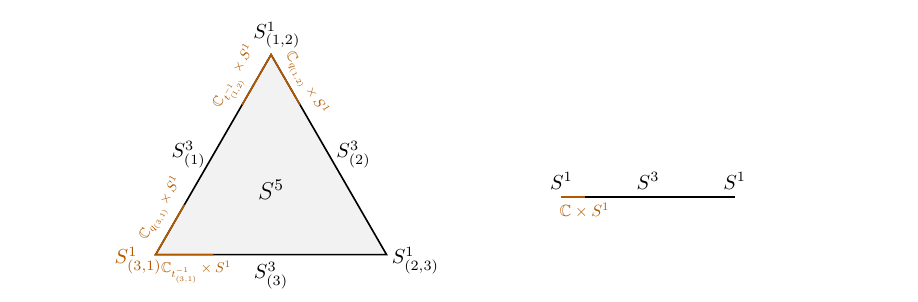
inside the three S 3 , whose Ω -deformation ( i , j ) ( i )